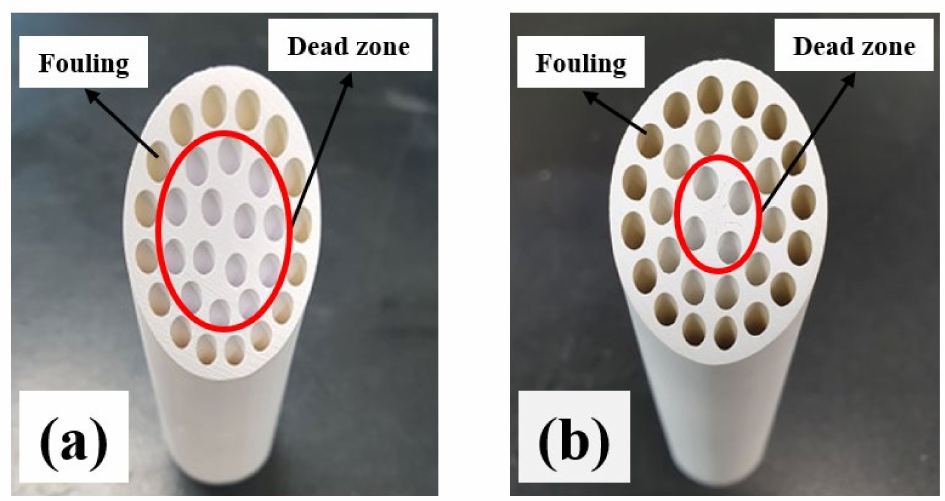
Figure 8. Cross-section of a multichannel cylindrical tube after pure water permeability test. ( a ) As-prepared support and ( b ) microfiltration membrane